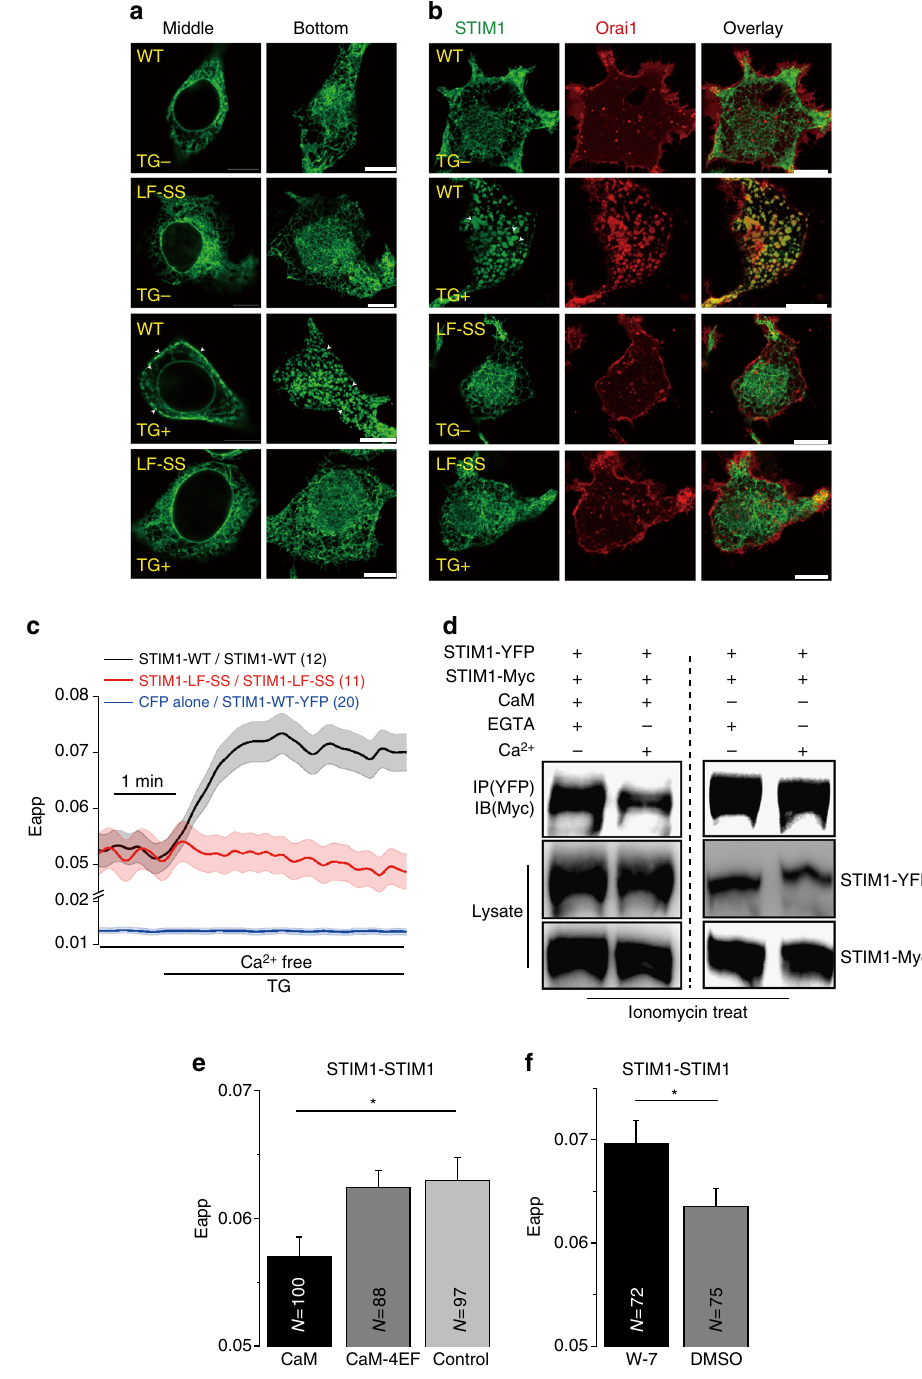
Fig. 6 Ca 2+ -CaM disassembles the STIM1 oligomer. a , b Confocal images of live HEK293T cells that were transfected with STIM1-GFP (WT or mutant) alone or co-transfected with Cherry-Orai1 before and after 1 μ M TG stimulation. Puncta are indicated by the arrow. Scale bars are 10 μ m. c FRET was measured between WT or mutant with COOH-terminus CFP- and YFP-tagged STIM1 in HEK293T cells. TG (1 μ M) was used to induce Ca 2+ depletion. d Western blot analysis of Ca 2+ -CaM protein competitive binding with STIM1 intermolecular interactions in HEK293T cells. Ionomycin (3 μ M) was used to induce Ca 2+ depletion before lysis. e Steady-state FRET between STIM1-CFP and STIM1-YFP that were co-expressed with CaM or CaM-4EF mutant in HEK293T cells after 3 μ M ionomycin treatment. f Steady-state FRET between STIM1-CFP and STIM1-YFP pretreated with 30 μ M W-7 or DMSO control for 30 min after 3 μ M ionomycin treatment in HEK293T cells. Numbers of cells analyzed are indicated. * P < 0.05 (unpaired Student ’ s t -test). Error bars denote